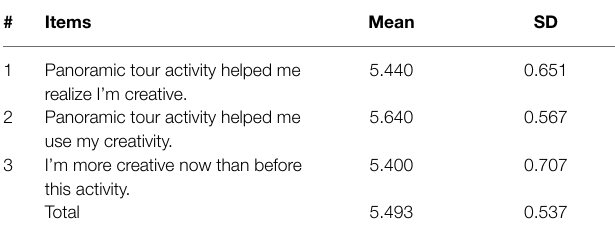
TABLE 4 | Perceived changes in creativity.